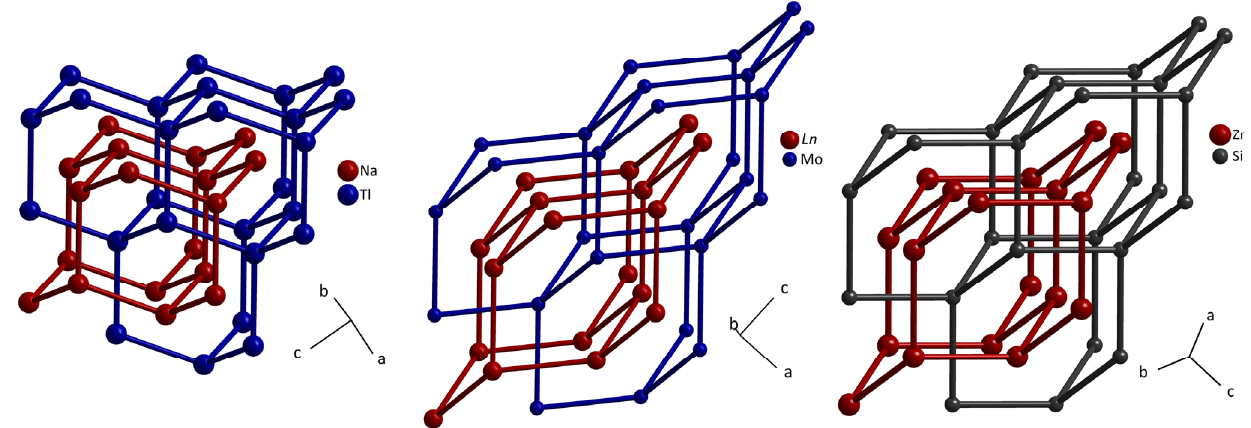
Figure 2. Excerpt from the crystal structures of NaTl ( left ), scheelite Ca[WO here: Ln [MoO ]), and zircon Zr[SiO 0.667 4 interpenetrating diamond -like lattices resulting from the "deoxygenated"